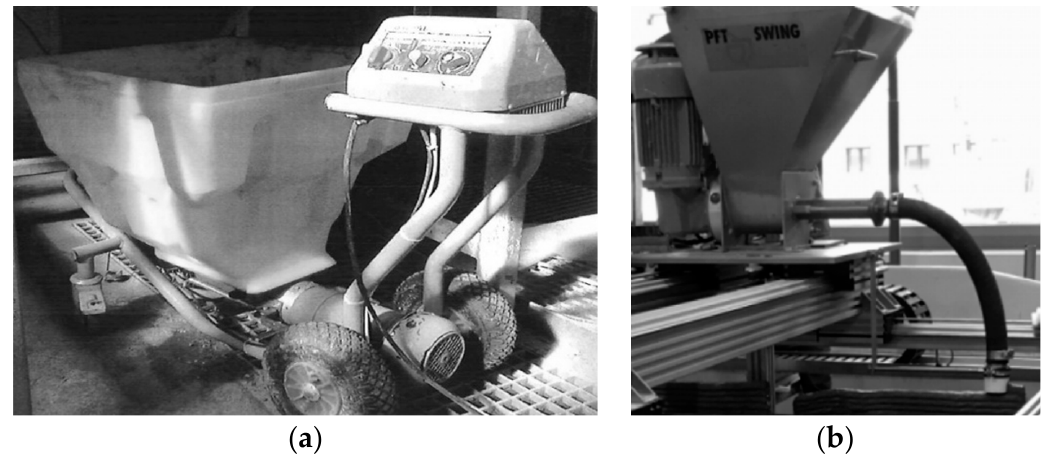
Figure 4. ( a ) The standalone progressive cavity pump (PCP), DUROPACT DP 326S, and ( b ) 3D concrete printing test device